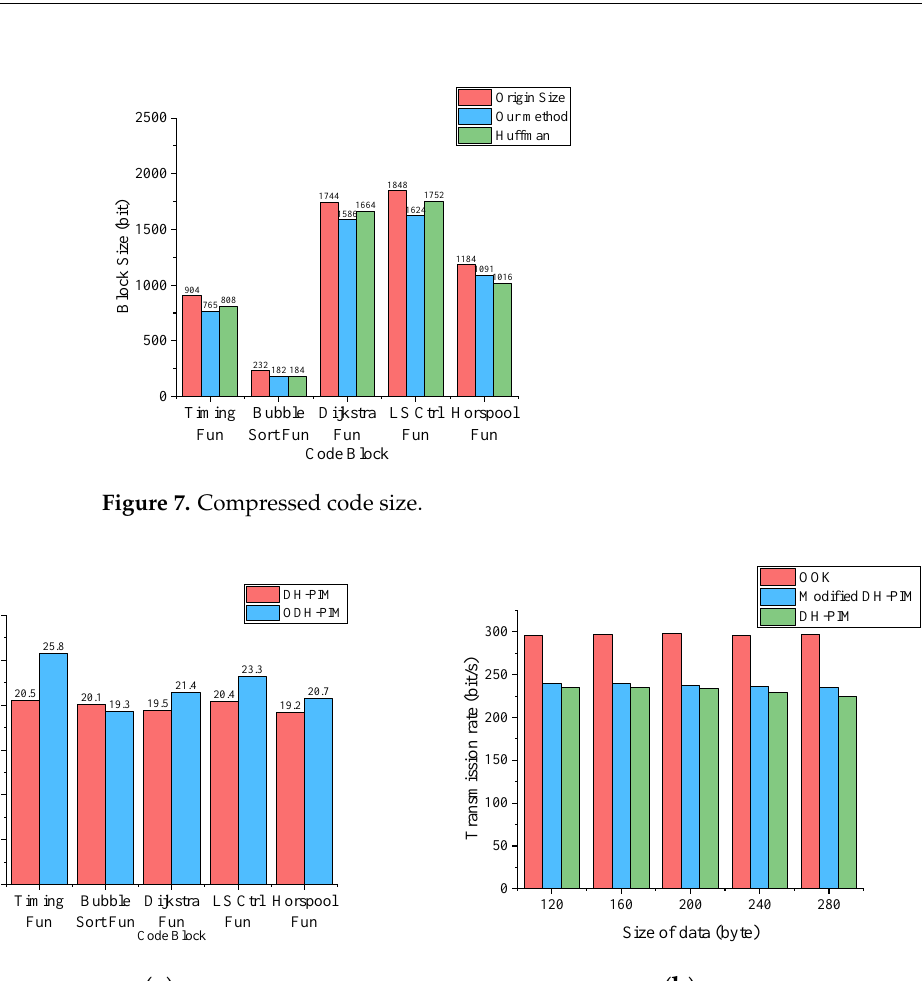
process is the transmission of the debugging codes. In contrast, the code block’s com- pression occupies a small time period due to the computing power of smartphone. The door environment on average. Ambient light impacts uplink/downlink transmission and increases frame errors. To deal with frame errors requires extra retransmitting frame and prolong uplink/downlink transmission in outdoor environment. Moreover, the rebuilding time is relative to the size of the debugging code. The size of debugging codes is smaller, the rebuild time is